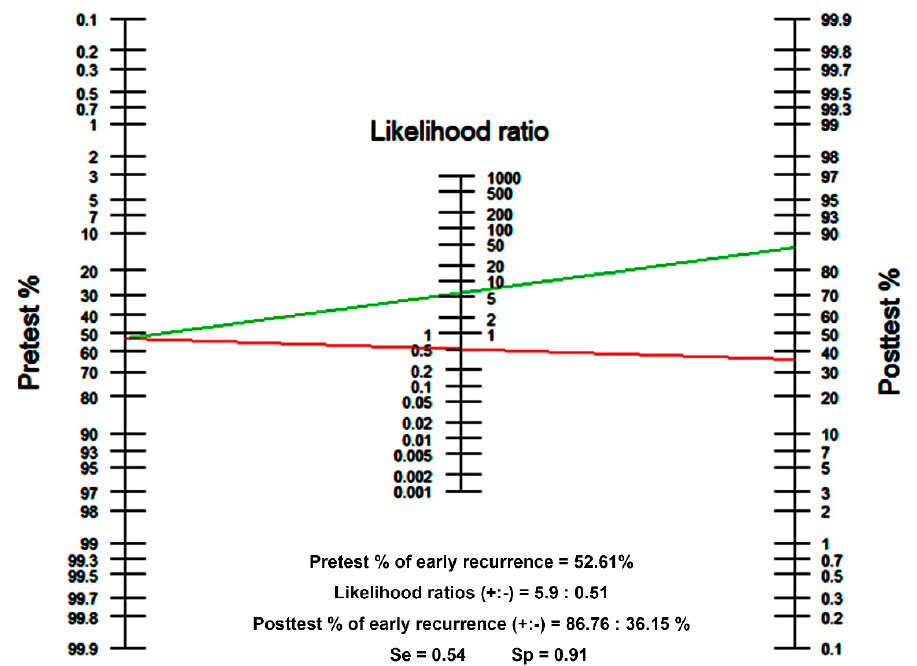
Figure 4. Fagan’s nomogram. The pretest probability of early recurrence is 52.61%. When the cut-off value of the predicted probability of early recurrence (within 12 months) is set to 0.71, the likelihood ratios of positive and negative test results are 5.9 and 0.51, respectively. The positive posttest probability of early recurrence (green line) is 86.76%, and the negative posttest probability of early recurrence (red line) is 36.15%.